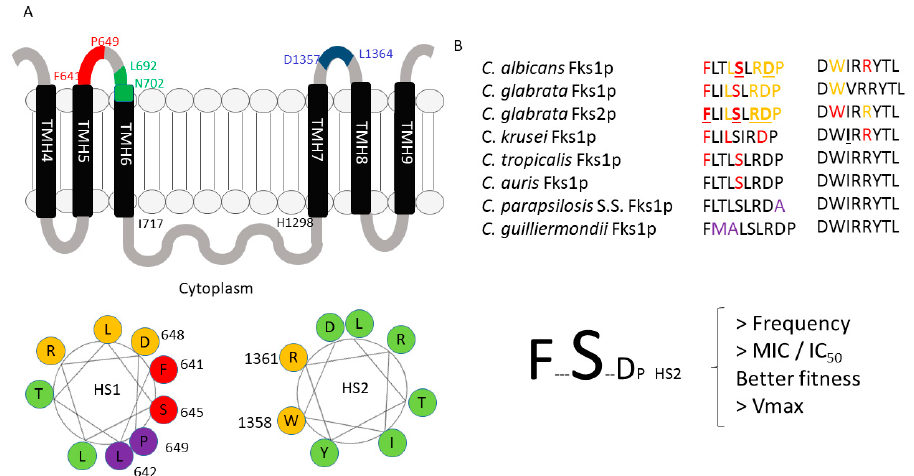
Figure 3. (( A ) above) Schematic representation (not in scale) of a portion of the Candida albicans Fks1p membrane topology on the basis of the Saccharomyces cerevisiae topology model (98). Black bars represent the transmembrane helices (TMH 4 to THM 9). Hot spot regions are colored in red (hot spot 1), in blue (hot spot 2), and in green (hot spot 3). Hot spot relative positions are not indented to represent the real position or the so-called echinocandin binding pocket. Putative glycosyltranferase domain (catalytic domain and substrate binding sites) is represented by a gray loop (I717-H1298). (( A ) below) Helical wheel representation showing the putative position of the amino acid of hot spot 1 (HS1) and hot spot 2 (HS2) of C. albicans Fks1p arranged in a α -helix seen from above [94]. The residues where mutations confer strong echinocandin resistance phenotype are represented in red; in orange, intermediate to low resistance phenotype [95]; and in purple, the residues that show low phenotype and are implicated in the so-called intrinsic reduced echinocandin susceptibility (IRES) phenotype in C. parapsilosis complex (P649A) and C. guilliermondii (L642M) [79,80]. The residues not linked with echinocandin resistance are represented in green. (( B ), above) Alignment of the hot spot regions of Candida spp. The residues linked with high level echinocandin resistance are represented in red; in orange, the residues that conferred low to intermediate resistance phenotype [96]; and in purple, the residues confirmed molecularly that are related with IRES phenotype [79,80]. In bold and underlined are the residues where spontaneous mutations were produced after in vitro exposure to high concentrations of rezafungin [97]. (( B ), below) Simplified representation of the relative frequency of appearance of each substitutions in clinical isolates together with its main characteristics (highest the size, the highest Minimal Inhibitory Concentration (MIC)/ and half enzyme maximal inhibitory concentration 50% (IC 50 ), Vmax, and better fitness) [51,52,60,98,99].